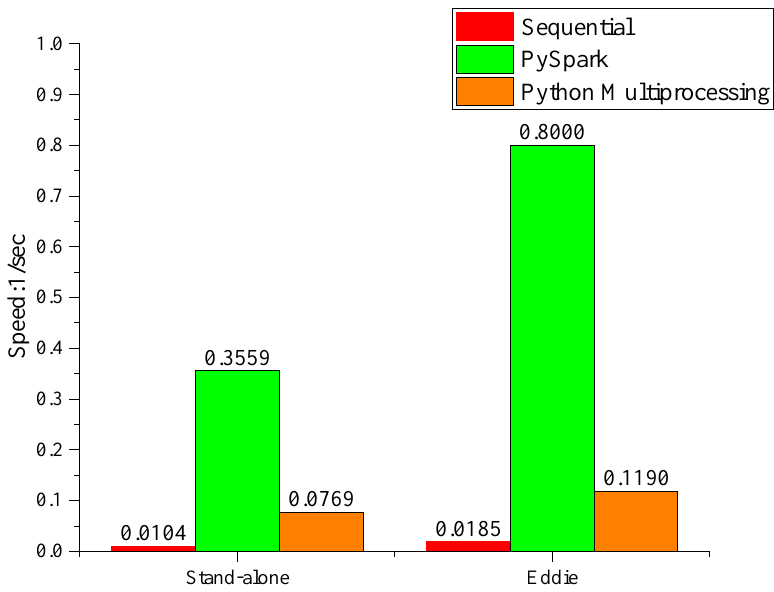
Figure 7. Processing speed (1/second) for sequential DMAS and its parallel versions using Pyspark and Python multiprocessing on a standalone PC and on Eddie. The results show that the Pyspark- based algorithm performs